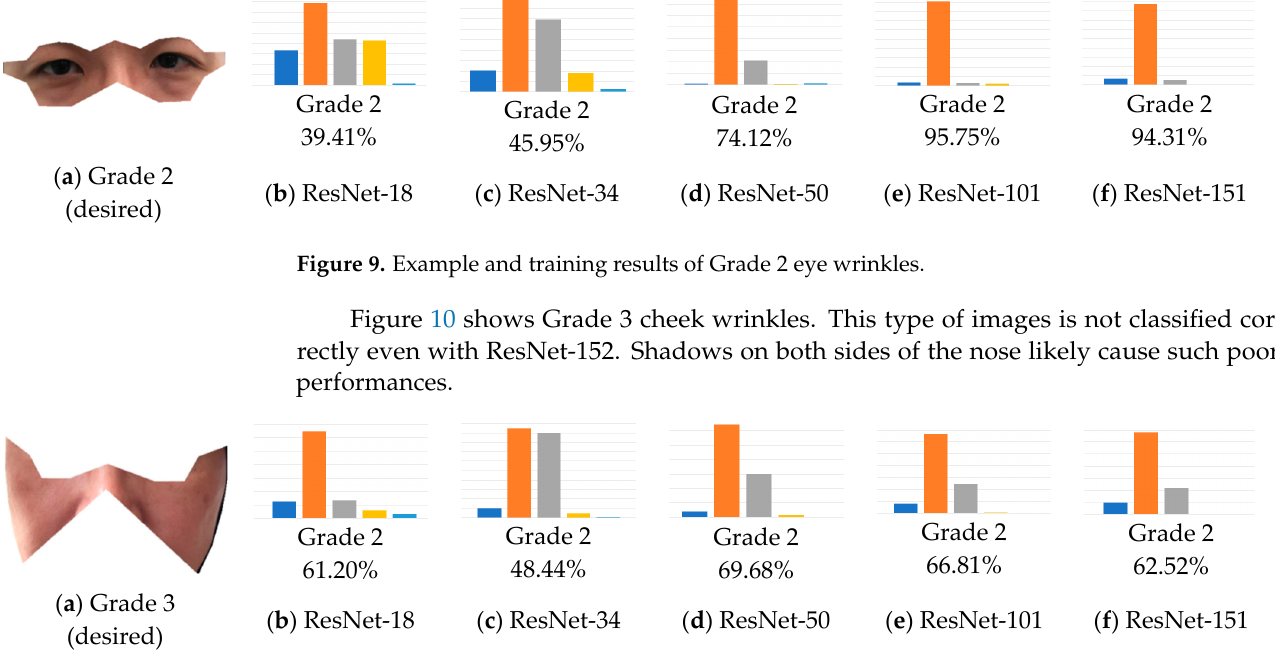
Figure 10. Example and training results of Grade 3 cheek wrinkles (wrongly classified grades are underlined).